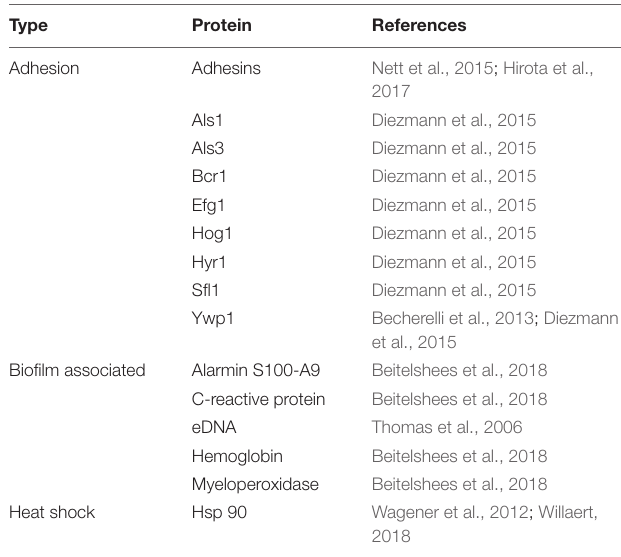
TABLE 2 | Differential expression of the proteins involved in biofilm formation in Candida